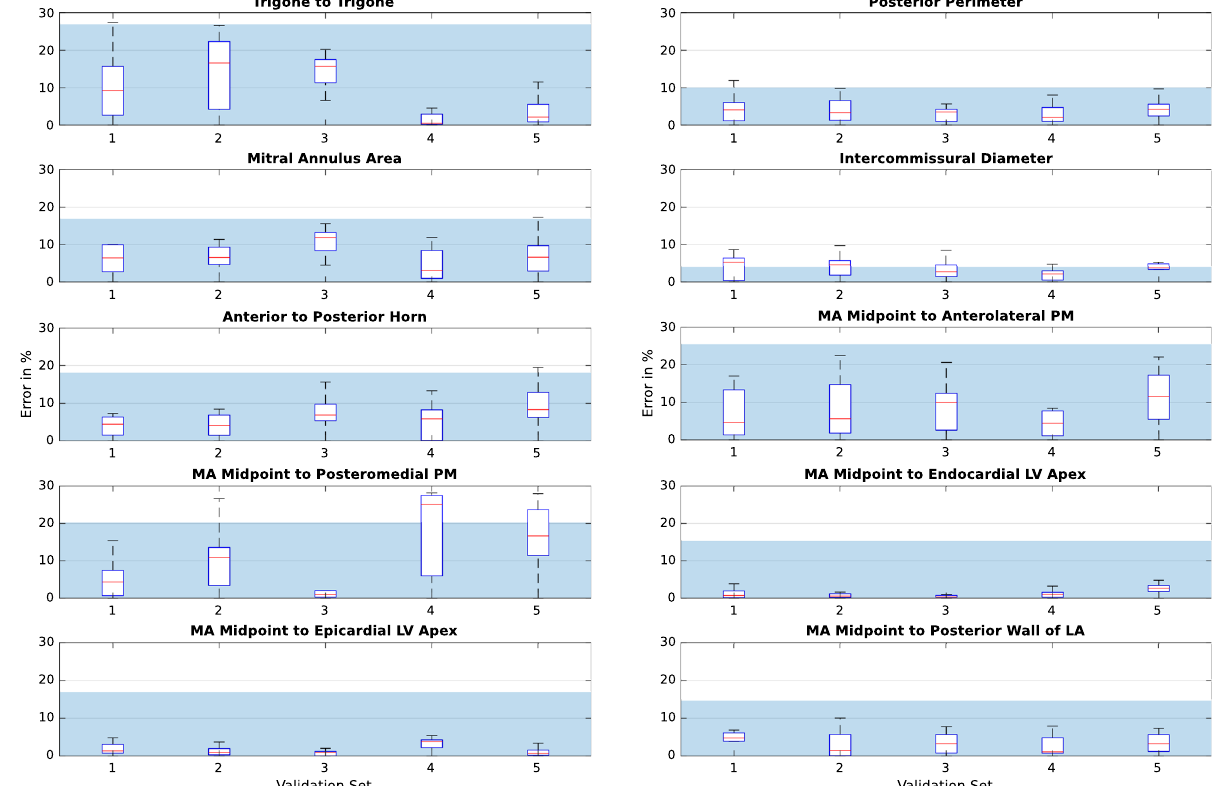
Figure 4. TSFFD tracking error, where X axis is the validation set. Y axis displays the error calculated in percentage. Each box plot represents the error in percentage from all the 500 measurements throughout the cardiac cycle. Mean intra-observer error across all sets is illustrated as a shaded